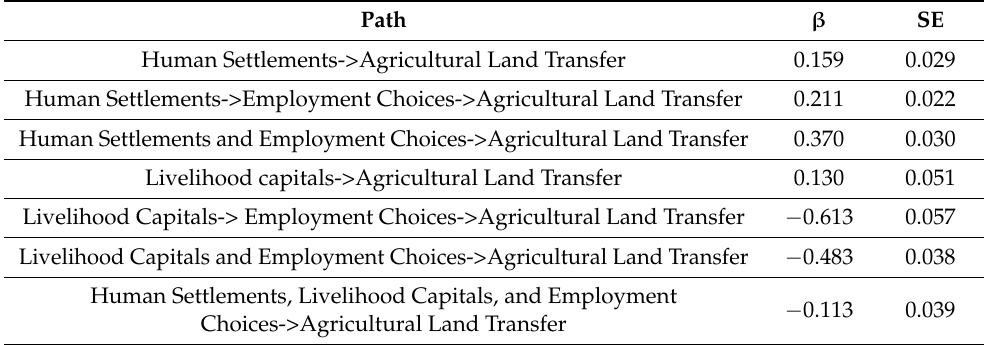
Table 5. Direct, indirect, and total effects of livelihood capitals and human settlements on agricultural land transfer. Path β SE Human Settlements->Agricultural Land Transfer 0.159